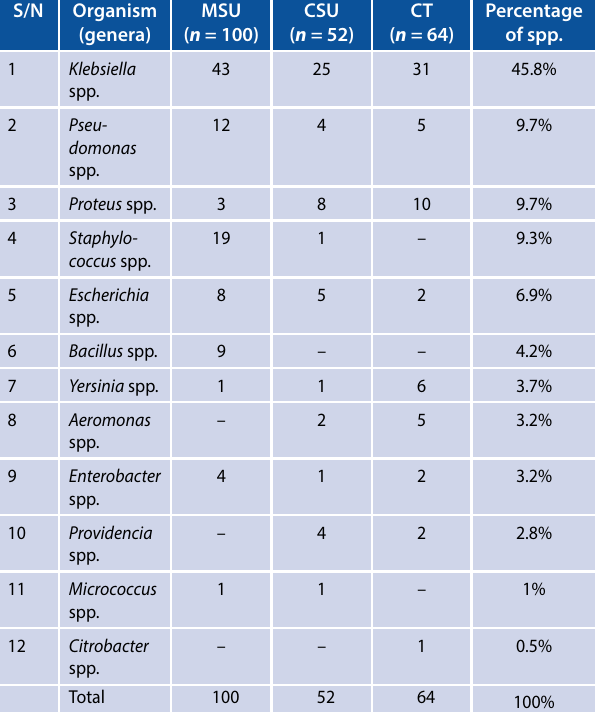
Table 1: Bacterial isolates from the mid-stream urine (MSU), catheter- stream urine (CSU) and catheter tips (CT) S/N Organism (genera)